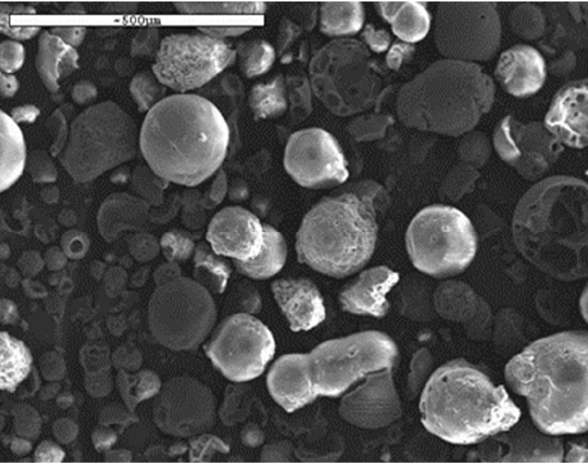
Figure 4. Lignin particles under SEM .